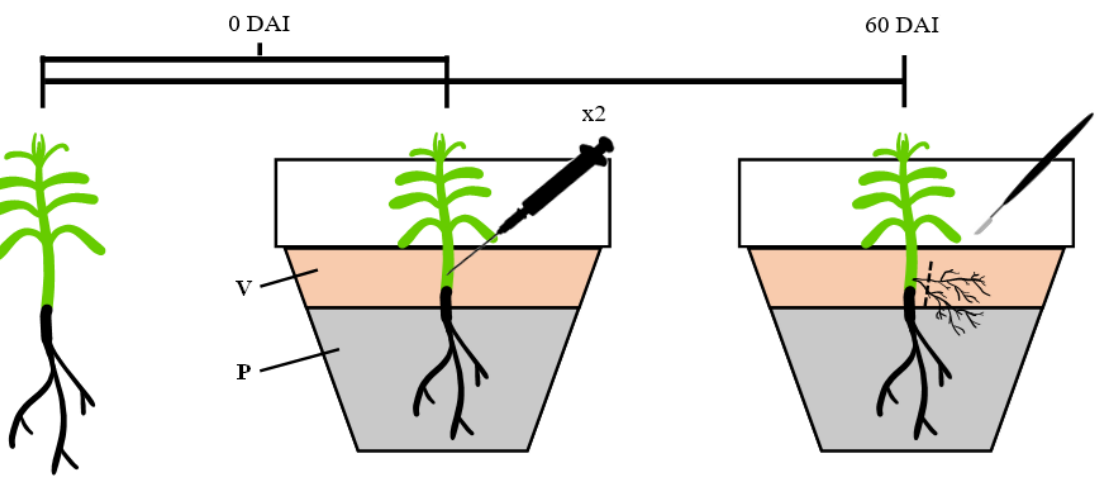
Figure 2. Schematic representation of the inoculation of ex vitro seedlings by the direct inoculation method. DAI: days after inoculation; V: vermiculite; P: